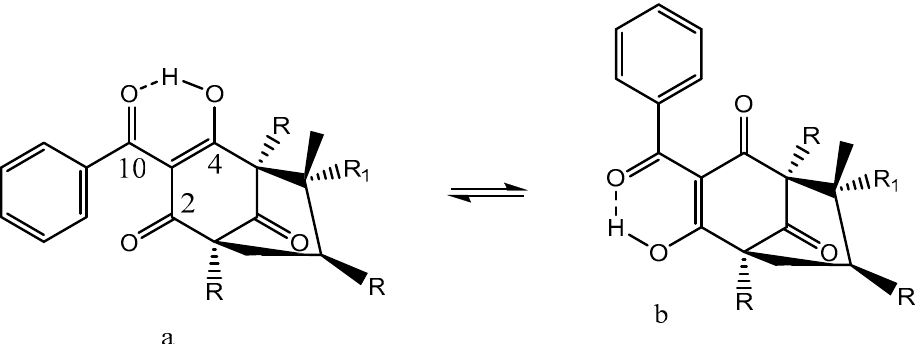
Figure 10. Tautomeric equilibrium of garciniaphenone (R = isoprenyl and R 1 = methyl) and 7- epi - clusianone (R = isoprenyl, R 1 = H). ( a ) and ( b ) are different positional enol isomers.